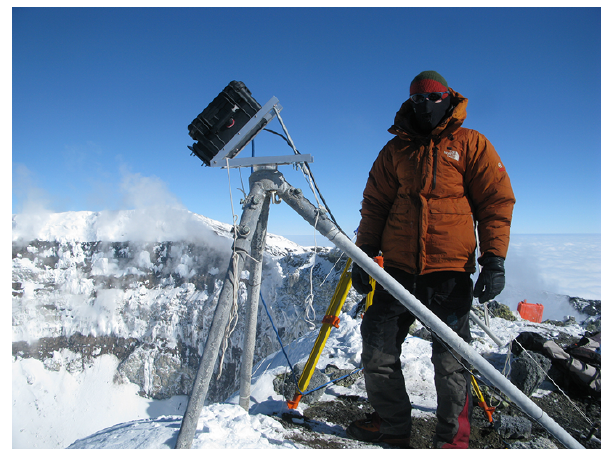
Fig. 4. The new thermal camera system installed at the crater rim of Erebus